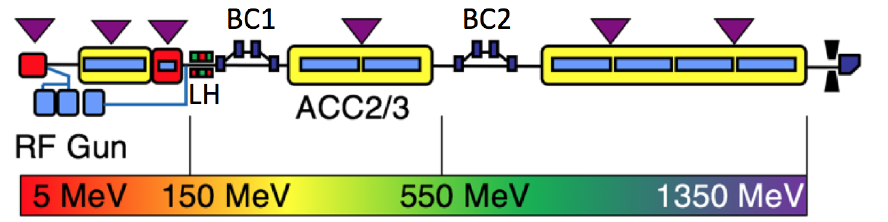
Figure 1. Sketch of the FLASH linac with planned laser heater (LH) and new bunch compressors (BC1, BC2) and the energy gain after the FLASH2020+